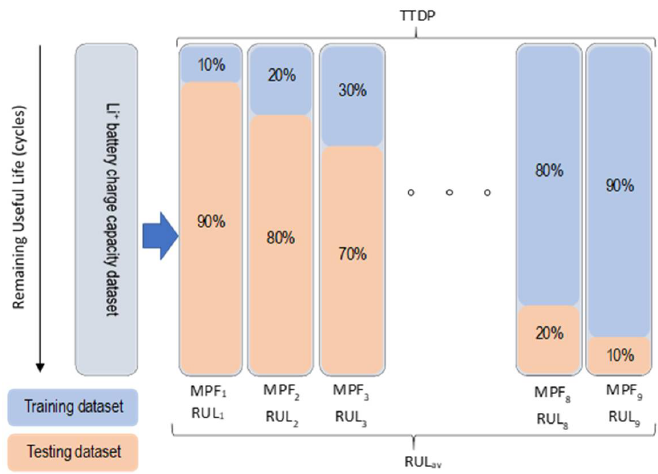
Figure 5. A 9-fold multi-level particle filter (MPF) cross-validation ensemble used for the computation of the RUL of the lithium-ion batteries at the different training/testing dataset partitions (TTDP).